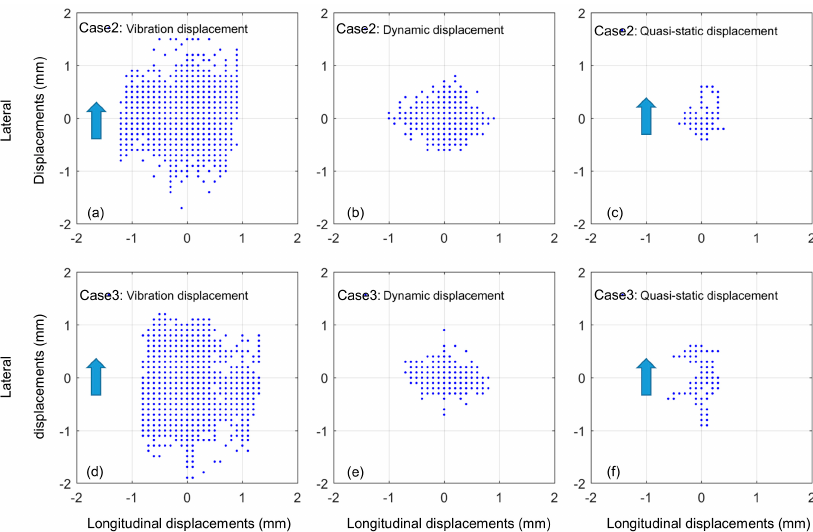
Figure 10. The distribution ranges of the longitudinal and lateral displacements of the measuring point of the studied footbridge, derived from the composite instrument measurements. The overall vibration displacements ( a ), dynamic displacements ( b ) and quasi-static displacements ( c ) in Case 2, and the corresponding ones ( d – f ) in Case 3. The distribution range of the overall vibration displacements in the lateral direction are significantly larger than the ones in the longitudinal direction as shown in subfigure ( a ). This is because the direction of the wind is along the lateral direction of the bridge, with blue arrows indicating the direction of the wind. Similar results can be found in subfigures ( c , d ), and ( f) .